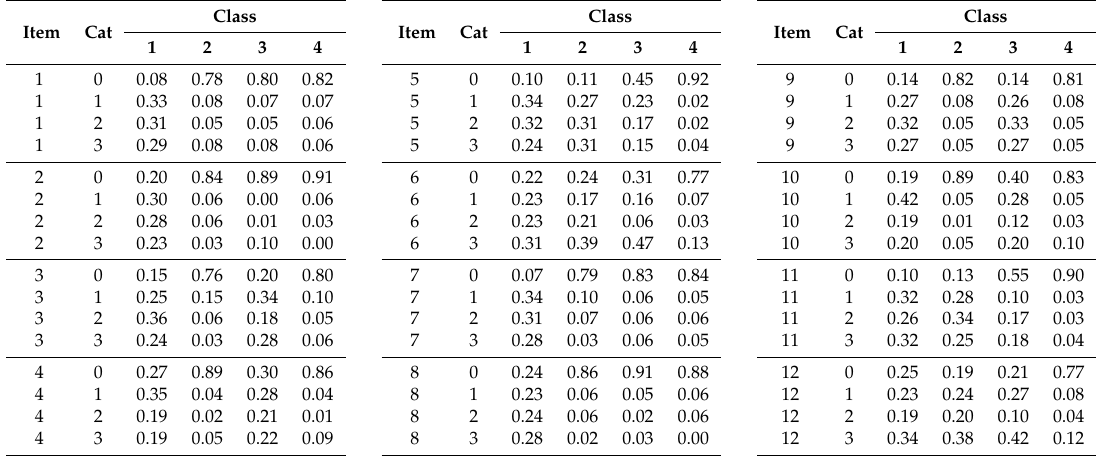
Table A1. Data illustration polytomous data: estimated item response probabilities in the exploratory LCM with C = 4